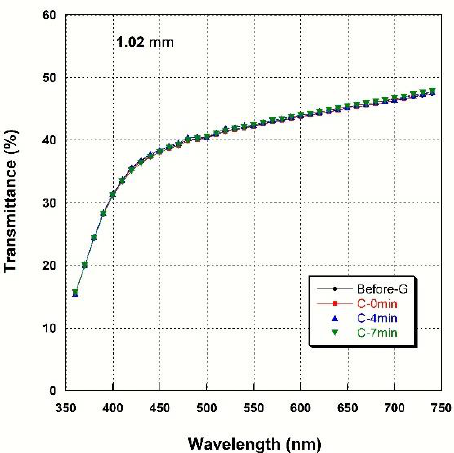
Figure 2. Spectral transmittance curves for various cooling rates at a thickness of 0.52 mm.